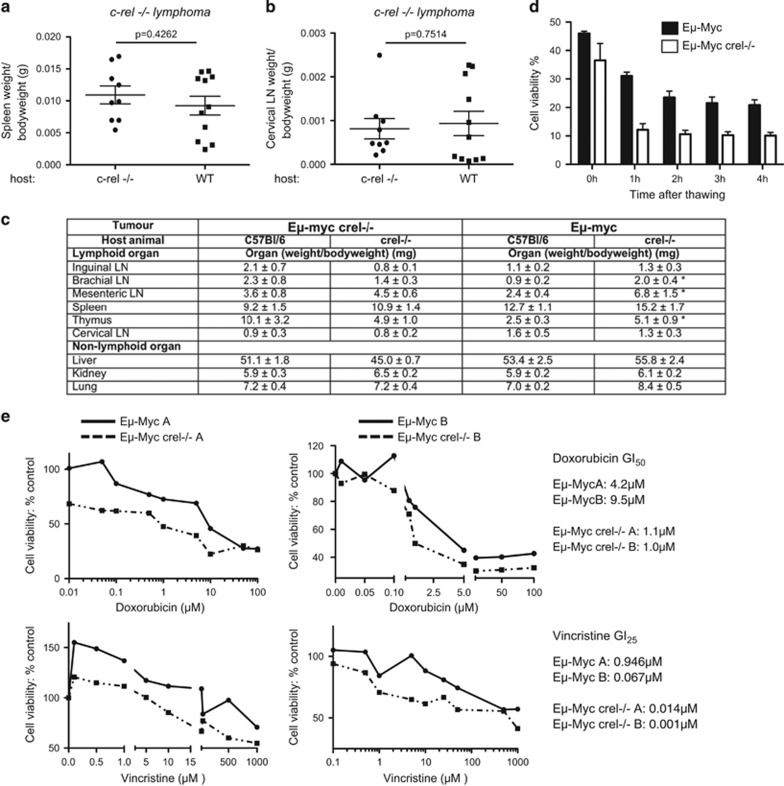
Eμ-Myc/c-rel–/– tumours grow equally well in wild-type and c-rel–/– mice and are more sensitive to apoptotic stimuli. (a, b) Reimplanted Eμ-Myc/c-rel–/– tumours grow equally well in wild-type and c-rel–/– mice. Lymph node tumours derived from three different Eμ-Myc/c-rel–/– mice were reimplanted in parallel into either three wild-type (C57Bl/6) or three c-rel–/– host mice. Four weeks after implantation, the mice were killed and tumour sizes at different sites were assessed. Data shown here are from the spleen (a) and cervical lymph nodes (b). Data representing mean±s.e.m. and P-values were calculated using Student's unpaired t-tests. (c) Tumour burden in lymphoid organs (weight of organ/bodyweight of animal in gram) following reimplantation of either Eμ-Myc or Eμ-Myc c-rel–/– tumour cells into either C57Bl/6 or c-rel–/– mice. Data shown are the means of three independent tumours each implanted into three mice±s.e.m. *P<0.05 in an unpaired Student's t-test, but otherwise there were no significant differences between tumour burden in wild-type and c-rel knock-out animals at any of the sites assessed. (d) Cell viability of Eμ-Myc and Eμ-Myc/c-rel–/– tumour cells grown ex vivo. Cell viability was measured using the trypan blue exclusion assay over a 4-h period after freeze thawing. (e) Eμ-Myc/c-rel–/– tumour cells are more sensitive to apoptotic stimuli. Freshly isolated Eμ-Myc or Eμ-Myc/c-rel–/– lymph node tumour cells (5 × 105 per well) were seeded into 96-well plates. Increasing concentrations of the chemotherapeutic agents, doxorubicin (Sigma-Aldrich) or vincristine (Sigma-Aldrich) or solvent controls were added to three replicate wells. After 96 h, viability was quantified using the CellTiter96 AQueous One Solution Cell Proliferation Assay (MTS; Promega), according to the manufacturer's instructions. Single-cell suspensions were prepared from tumour-bearing organs of Eμ-Myc and Eμ-Myc/c-rel–/– mice upon necropsy. These were then used for downstream analyses or frozen in 90% fetal bovine serum/10% dimethyl sulfoxide for long-term storage and transplantation. For reciprocal microenvironment experiments, 2 × 106 Eμ-Myc/c-rel–/– lymph node tumour cells from male mice were transplanted intravenously via the lateral tail vein into 8-week-old male C57BL/6 or c-rel–/– recipients. Mice were necropsied when they became moribund and the tumour burden assessed. C57BL/6 mice used for reimplantation studies were purchased from Charles River (Margate, UK).